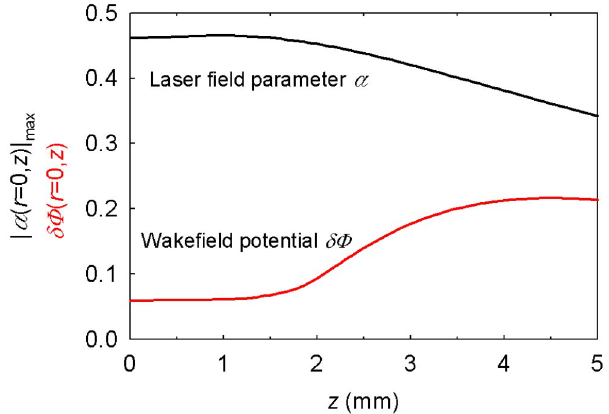
(cid:1) 2 : 97 ps . Also plotted are the d (cid:1) 12 ps and d